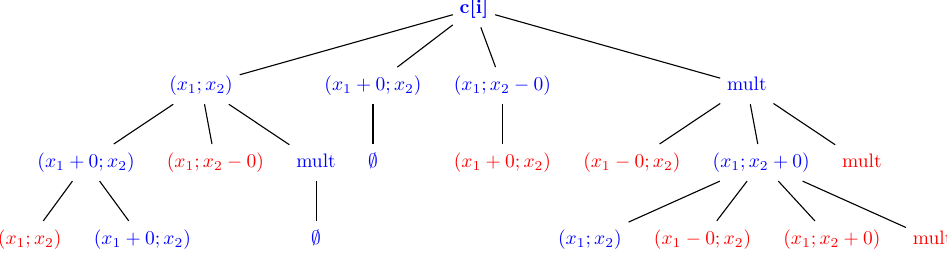
Figure 5: Expansion process for candidate c[i]. Pruned solutions are in